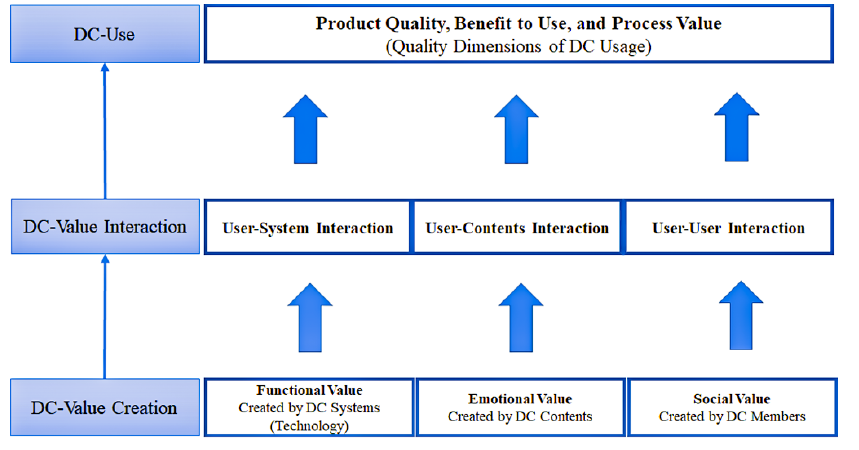
Figure 1. Digital content value chain framework.